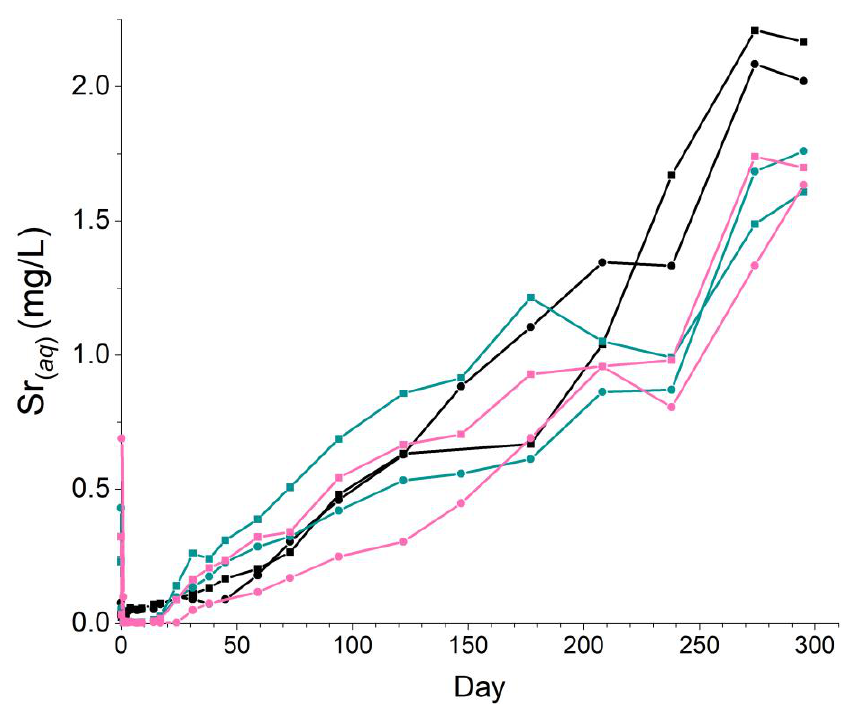
Figure 1. Concentration of Sr (aq) in the effluents for three column systems over 295 days: ( black ) rock flour, ( green ) rock flour + bentonite (6 wt.%), and ( pink ) rock flour + bentonite (6 wt.%) + steel coupons, after centrifugation at 1.4 × 10 4 g for 5 mins. Each system was conducted in duplicate, and individual columns (per system) are represented by squares and circles.